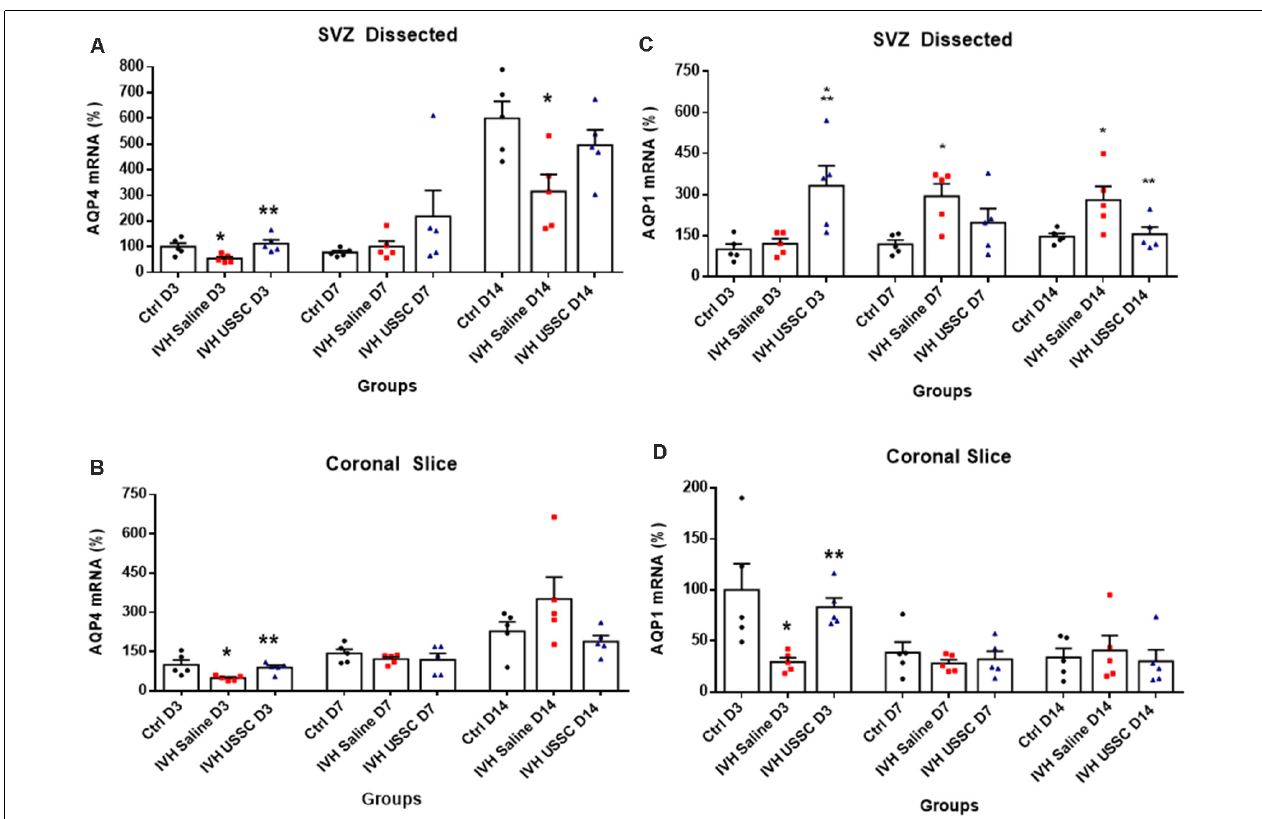
FIGURE 6 | USSC administration altered the expression of the AQP4 and AQP1 mRNA in Sub-ventricular zone (SVZ) and brain parenchyma in PHH. (A,B) Scatter plot with bar graphs showing TaqMan gene expression assay in microscopic dissected SVZ and coronal slice tissue mRNA for AQP4 expression. (A) SVZ dissected tissue mRNA showed reduced expression in IVH pups compared with controls at days 3 and 14 for AQP4, whereas after USSC treatment, the AQP4 expression was elevated to normal or above IVH group at both postnatal ages (* P < 0.05 for Ctrl vs. IVH, ** P < 0.05 IVH vs. USSCs, n = 5 in each group). The data represent mean ± SEM; for each group for three postnatal days 3, 7 and 14. P -values were derived by one-way ANOVA with Tukey’s multiple comparisons test. (B) Similar comparisons in coronal slice mRNA showed reduced AQP4 expression in IVH on day 3 that recovered to normal levels after USSCs at all time points (* P < 0.05 for Ctrl vs. IVH, ** P < 0.05 IVH vs. USSCs, n = 5 in each group). The data represent mean ± SEM; for each group for three postnatal days 3, 7 and 14. P -values were derived by one-way ANOVA with Tukey’s multiple comparisons test. (C,D) Scatter plot with bar graphs showing TaqMan gene expression assay in dissected